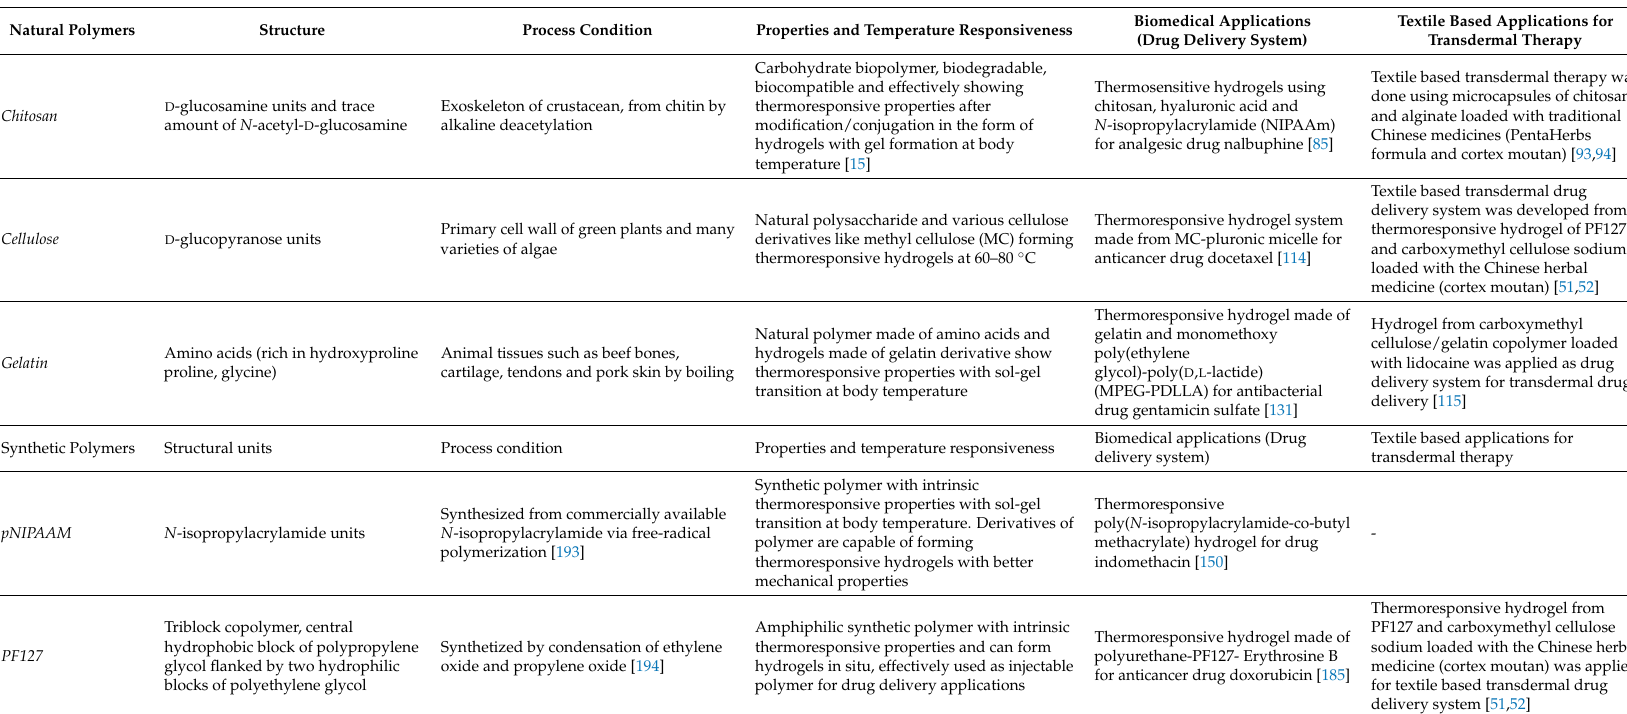
Table 1. An overall view of natural and synthetic polymers used in thermoresponsive hydrogels for drug delivery and transdermal therapy. Natural